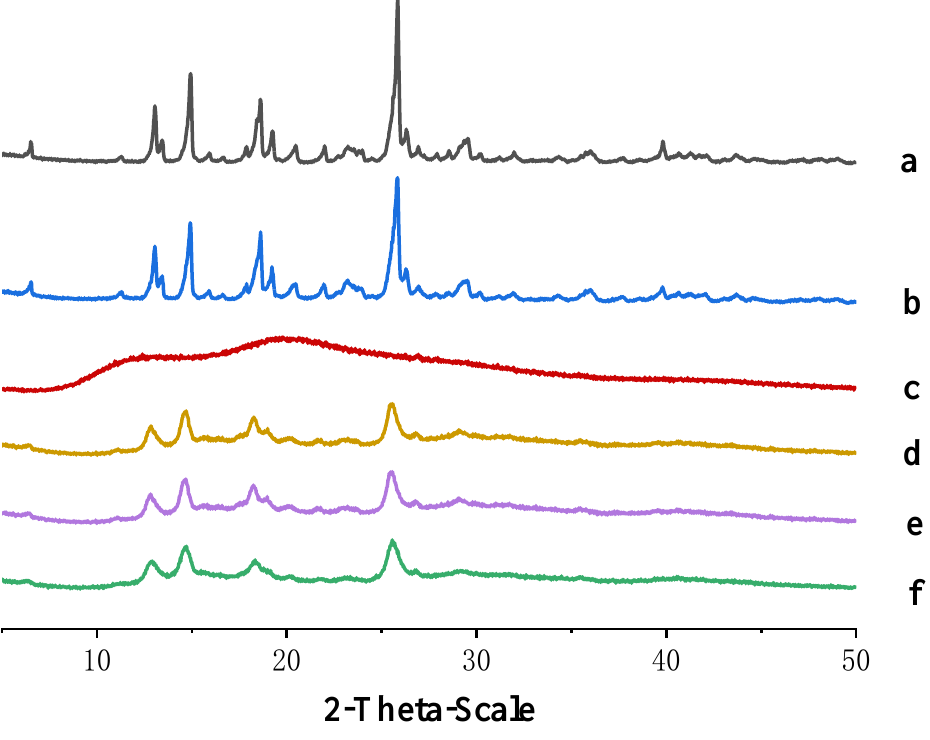
Figure 8. Powder X-ray diffractometry graphs (PXRD). ( a ) Pure MLX material; ( b ) physical mixture; ( c ) PVP-k17; ( d ) MLX-NCs-A; ( e ) MLX-NCs-B; ( f ) MLX-NCs-C.